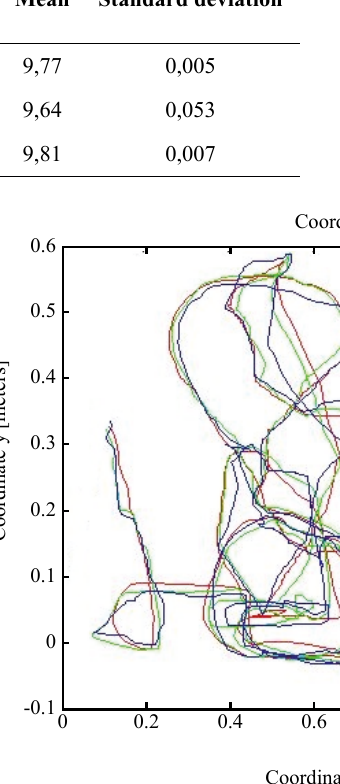
Table 1 - Values obtained by the evaluators from distance of 10 meters Measurements (m) Evaluator Mean Standard deviation 1°